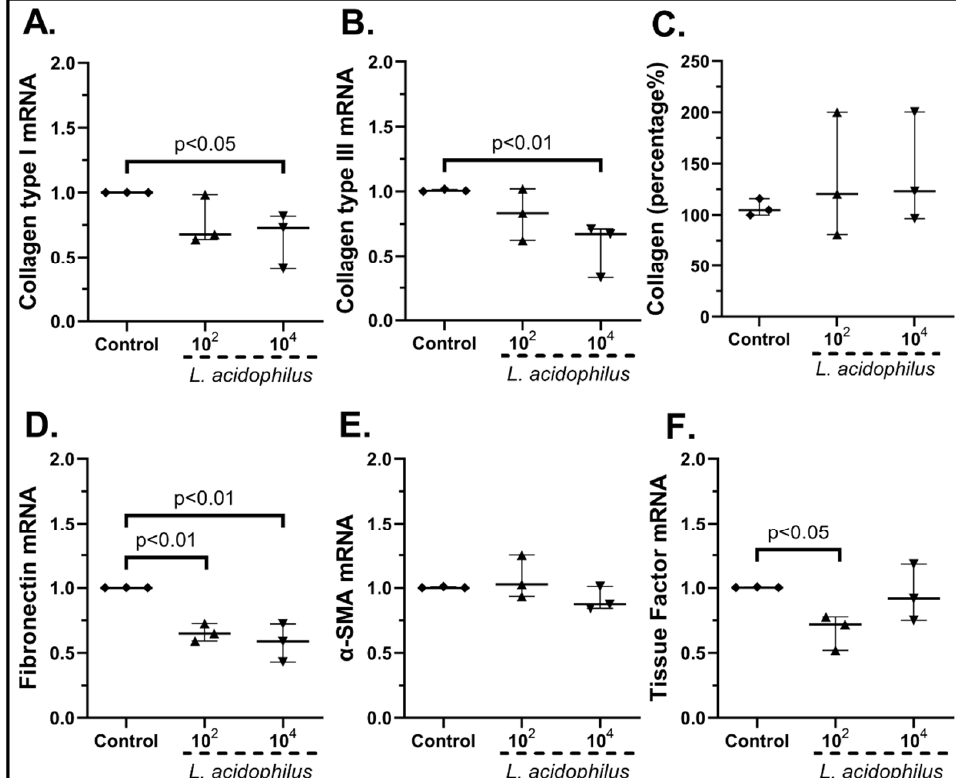
Figure 11. cSEMF mRNA expression of Collagen Type I ( A ), Collagen Type III ( B ), Fibronectin ( D ), α-SMA ( E ), Tissue factor ( F ) and Collagen secretion ( C ) after stimulation with Lactobacillus acidophilus. Results are presented as median with interquartile range. N = 3.